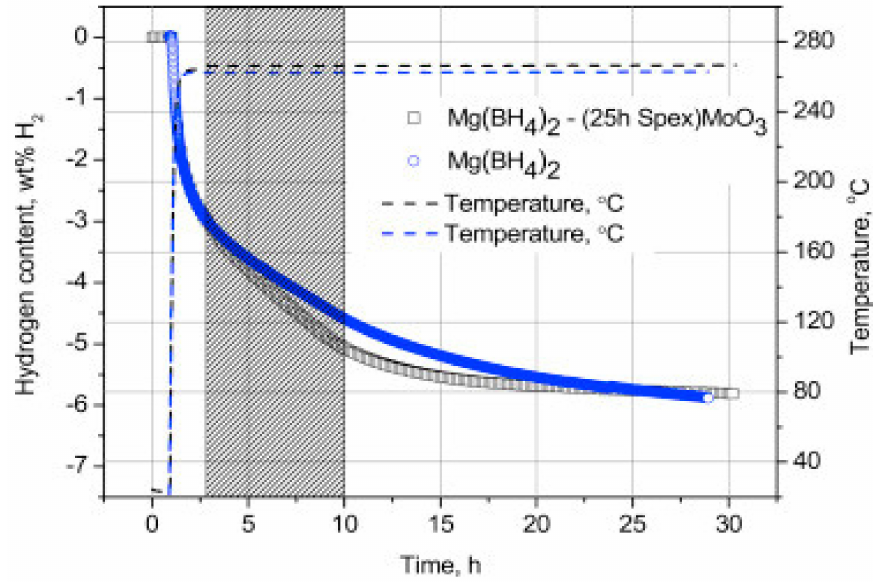
Figure 5. Hydrogen desorption curves of pristine γ -Mg(BH 4 ) 2 and γ -Mg(BH 4 ) 2 + 2 mol% MoO 3 [120].